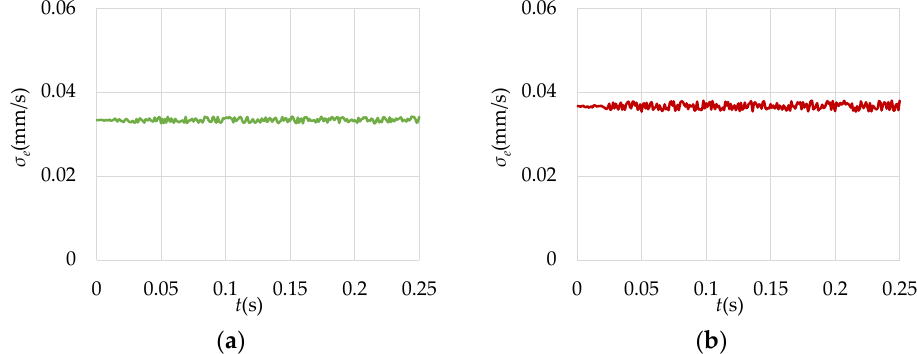
Figure 9. Consistency in tracking performance under Case (200, 175, 191, 50), ( a ) σ e ( t ) of FAFC, ( b ) σ e ( t ) of AFC.